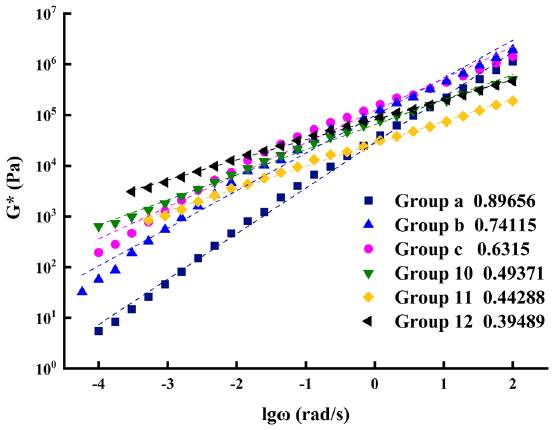
Figure 6. The linear fit curve of complex shear modulus (reference temperature: 30 °C).